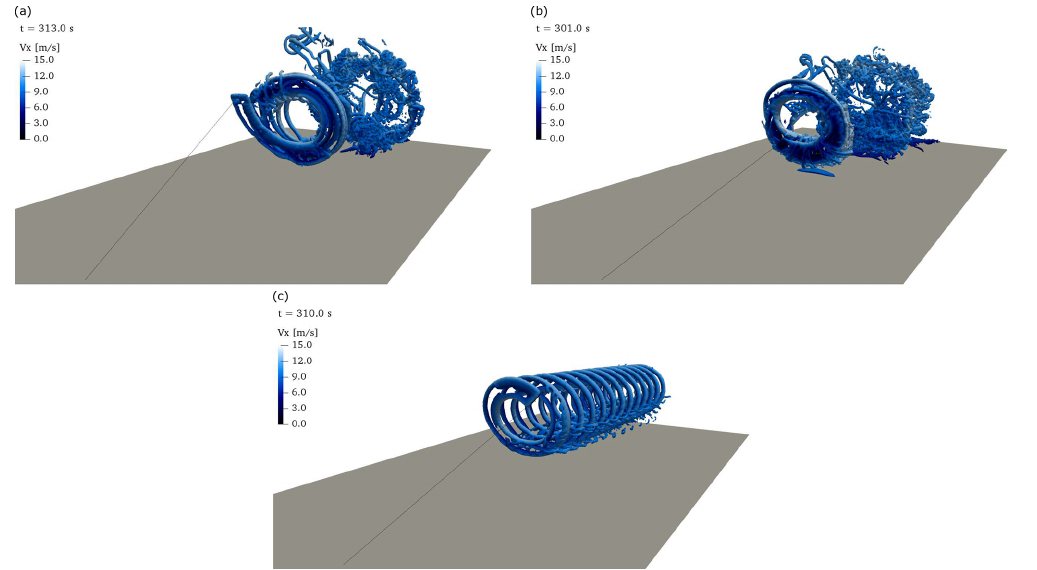
Figure A3. Instantaneous frontal snapshots of the wake field of reference lift- and drag-mode AWE systems operating in an unperturbed logarithmic inflow at a wind speed U D = 10ms − 1 . Isovolumes of positive Q criterion, coloured by streamwise velocity (cid:101) v x for (a) the lift-mode AWE system with induction-based limitation of reel-out speed at t = 313s, (b) lift-mode AWE system with original bounds at t = 301s, and (c) drag-mode AWE system at t =